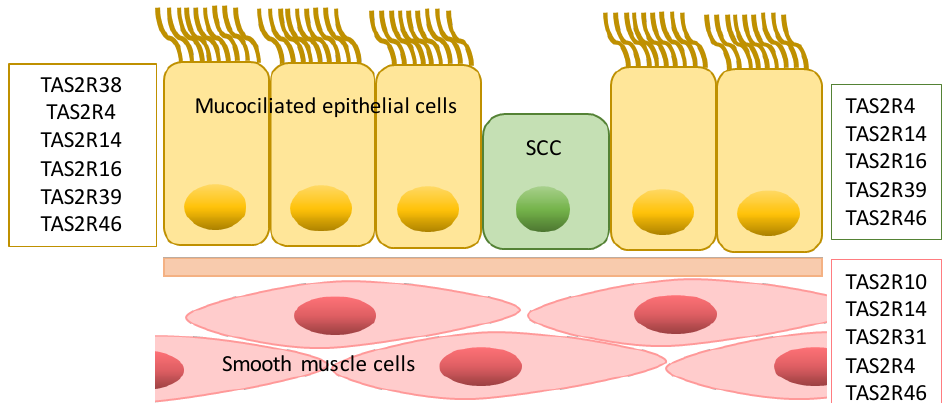
Figure 3. TAS2R expression pattern in airways cells. TAS2Rs expressed in mucociliated epithelial cells, in the solitary chemosensory cells (SCC) and smooth muscle cells are reported in the yellow, green and red boxes, respectively.